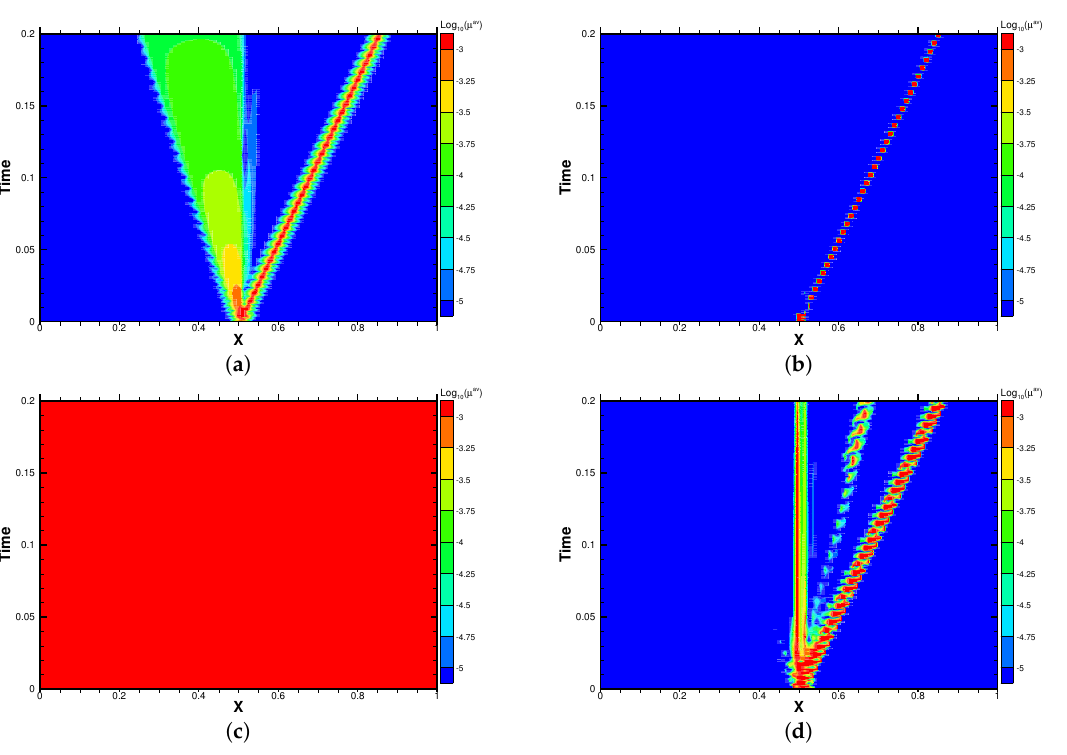
Figure 7. Temporal history of artificial viscosity for the one-dimensional Sod problem with 100 P 2 elements for t ∈ [ 0,0.2 ] . ( a ) DB; ( b ) MDH; ( c ) MDA; ( d )